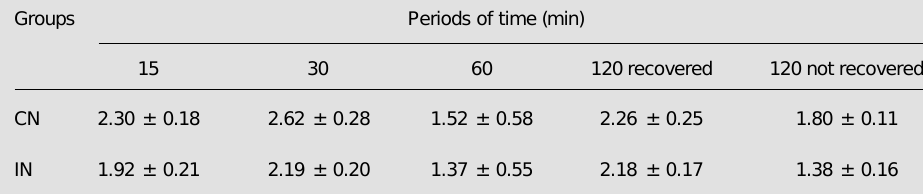
Table 2 - Liver glycogen content (mg%) determined 15, 30, 60, and 120 min after injection of insulin (IN group) or saline (CN group). Data are reported as the mean ± SEM for at least 5